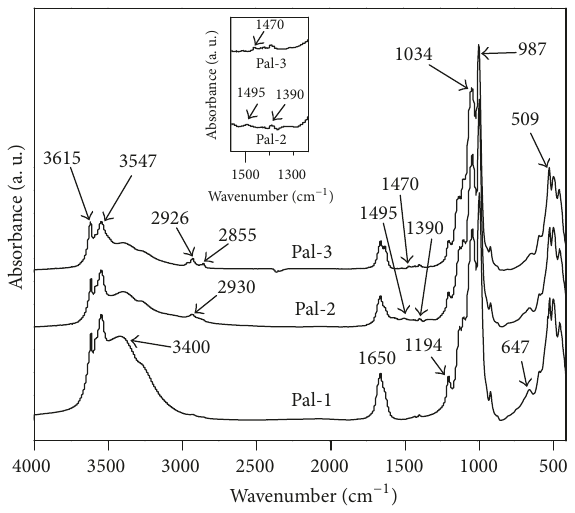
Figure 2: FT-IR spectra of Pal-1, Pal-2, and